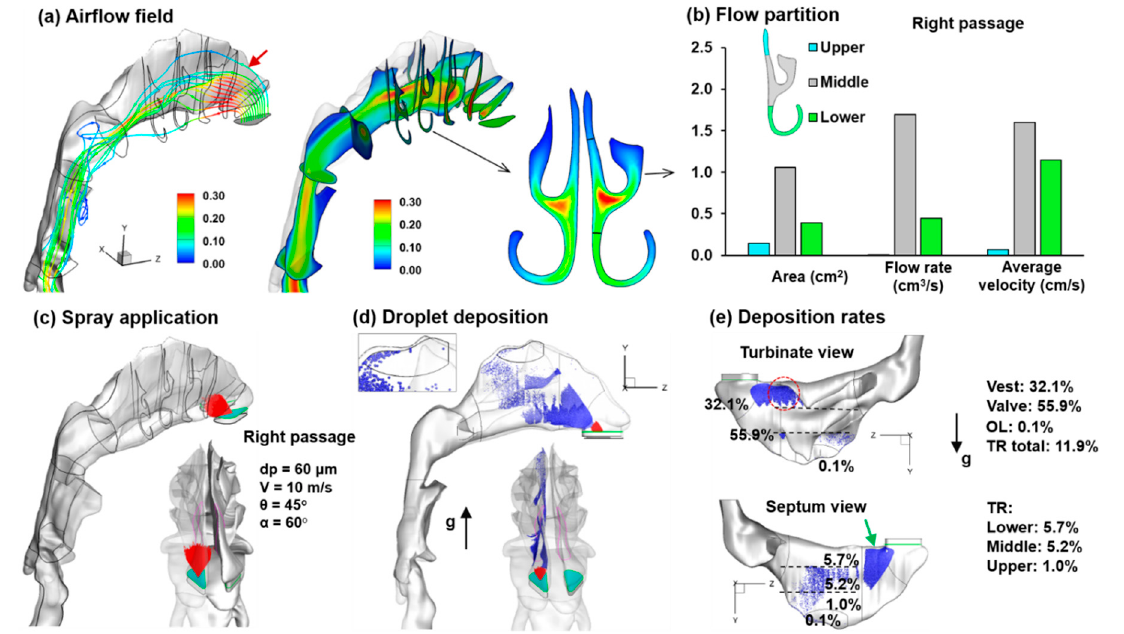
Figure 4. Velocity and spray dosimetry at the baseline condition (i.e., the device orientation α = 60° from the vertical): ( a ) streamlines and the midplane velocity contour at 1.8 L/min; ( b ) flow partition among the superior, middle, and inferior meatus; ( c ) nasal spray releasing, with the droplet size d p = 60 μ m, droplet velocity V = 10 m/s, plume angle θ = 45°, and the releasing position being 4 mm into the nostril; ( d ) the initial particle deposition, with very few particles deposited in the olfactory region; ( e ) subregional deposition fractions: 32.1% in the vestibule and 55.9% in the nasal (upper panel); 5.7% in the inferior meatus; 5.2% in the middle meatus; 1.0% in the superior meatus; 0.1% in the olfactory region.